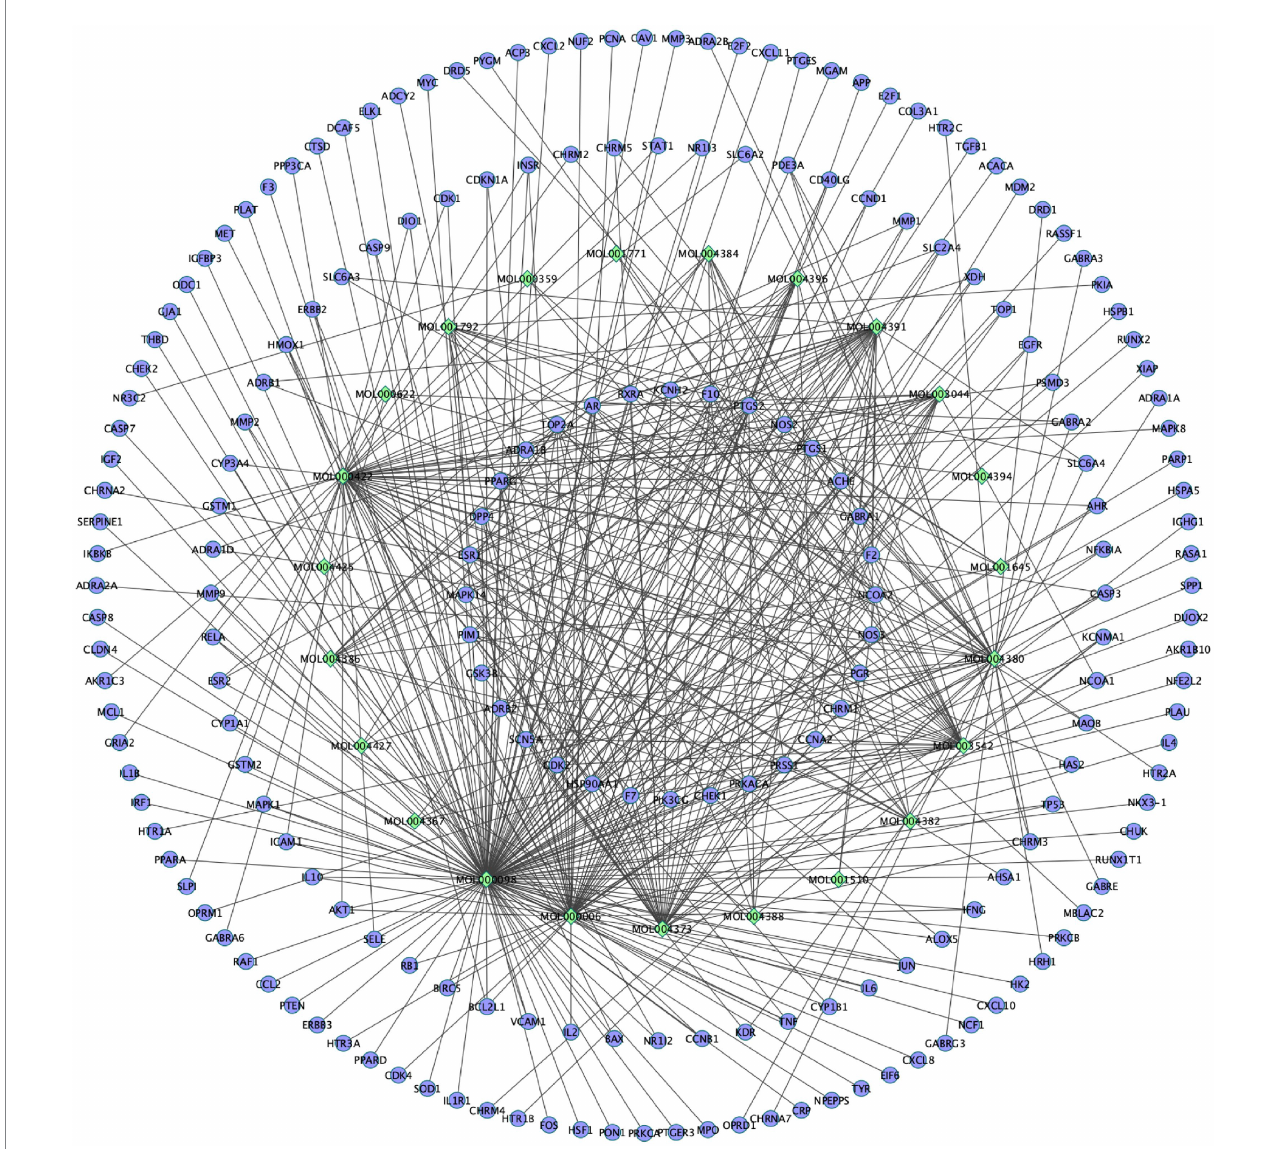
FIGURE 3 The compounds-targets network diagram of EPI to treat SCI. Rhombic nodes represent active ingredients in EPI, circular nodes represent 133 potential targets of EPI for